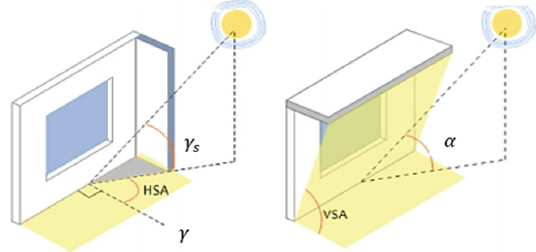
Figure 6. Shading Design Parameters. Window types 1 and 2 on the target façades were favoured for shading. Window